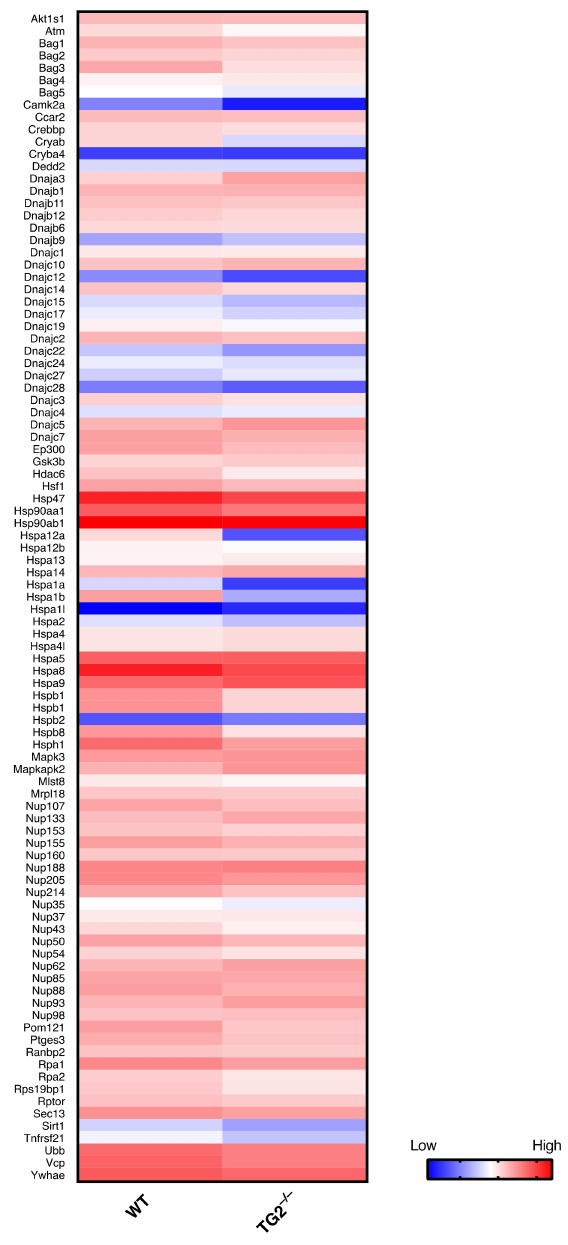
Figure 2. TG2-dependent regulation of HS. Heat map representing the expression of genes associated with the HS response in WT and TG2 knock out cells (TG2 − / − ) after HS induction. Higher expression is red, while lower expression is shown as